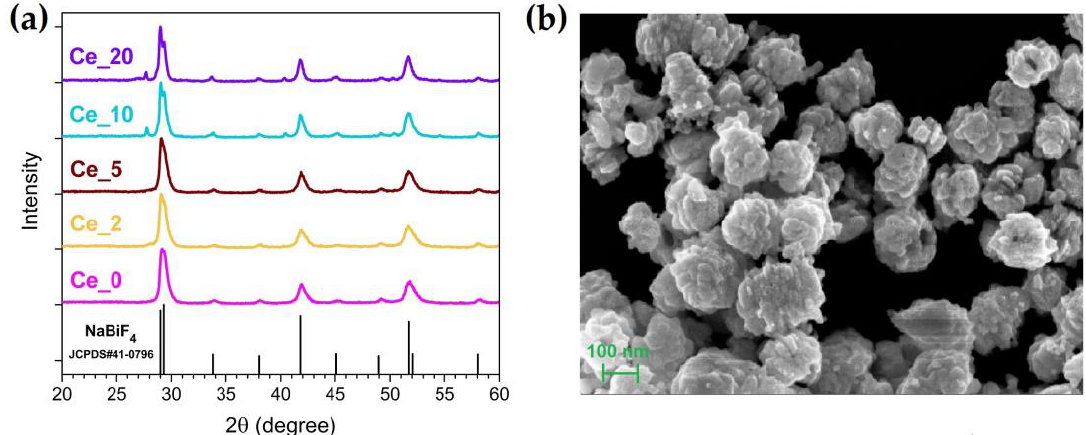
Figure 1. ( a ) XRPD patterns of the Ln 3+ -doped NaBiF 4 samples with different Ce 3+ content. ( b ) FE-SEM image of Ce_10 sample.